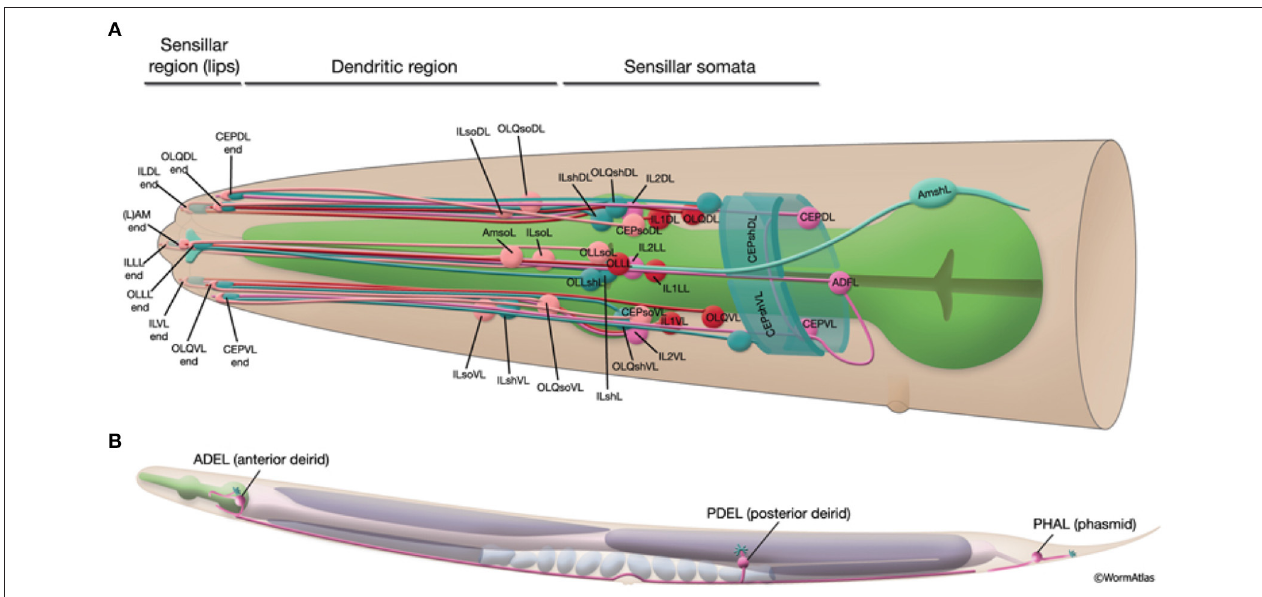
FIGURE 2 | Schematic presentation of the sensillar apparatus of the C. elegans . 20 sensilla organs in the head (A) and 3 pairs in the posterior to head region (B) . Only the left sensilla are shown. The figure has been reproduced with permission from WormAtlas (Altun and Hall, 2010).